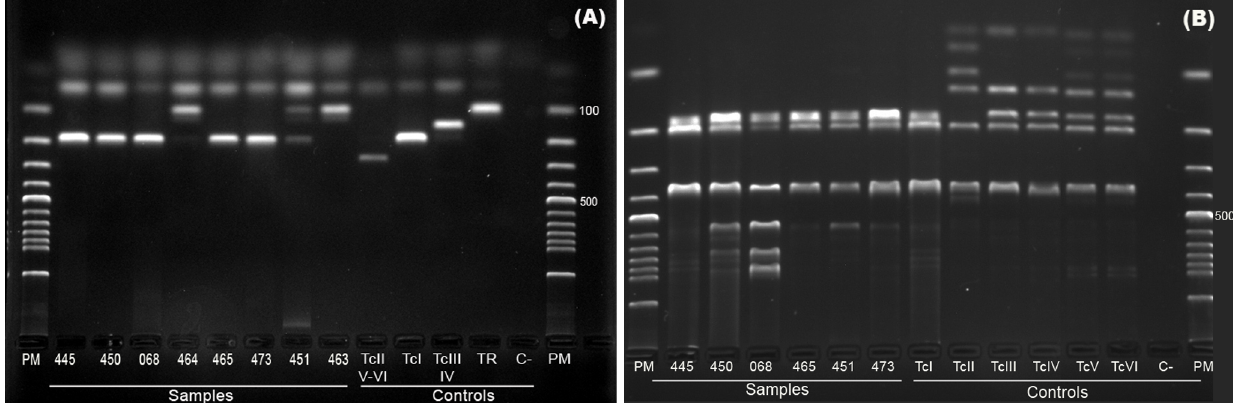
Figure 2. Trypanosomacruzi genotyping of triatomine and mammalian isolates from the Bele´m/Para´, Brazil. (A) PCR products of the mini-exon gene analyzed by electrophoresis on na agarose gel stained with ethidium bromide. Lanes: M. molecular-weight markers (100 bp DNA ladder); control samples: TcI (200 bp), TcII/TcV/TcVI (250 bp), TcIII/TcIV (150 bp), and T. rangeli (100 bp). (B) PCR-RFLP products of 1f8 gene/Alw21I. Control samples: PCR-RFLP 1f8/Alw21I digestion patterns of TcI to TcVI: 445, 450 and 068: triatomine isolates ( Rhodinius pictipes from Combu, Murutucu and Val-de-Ca˜es, respectively) characterized as TcI; 464: dog isolate characterized as T. rangeli ; 465: dog isolate characterized as TcI; 473: Philander opossum isolates characterized as TcI; 451: P. opossum isolate characterized as a mixed infection of TcI/ T. rangeli ; and 463: P. opossum isolate characterized as T. rangeli . doi:10.1371/journal.pntd.0002878.g002 PLOS Neglected Tropical Diseases |